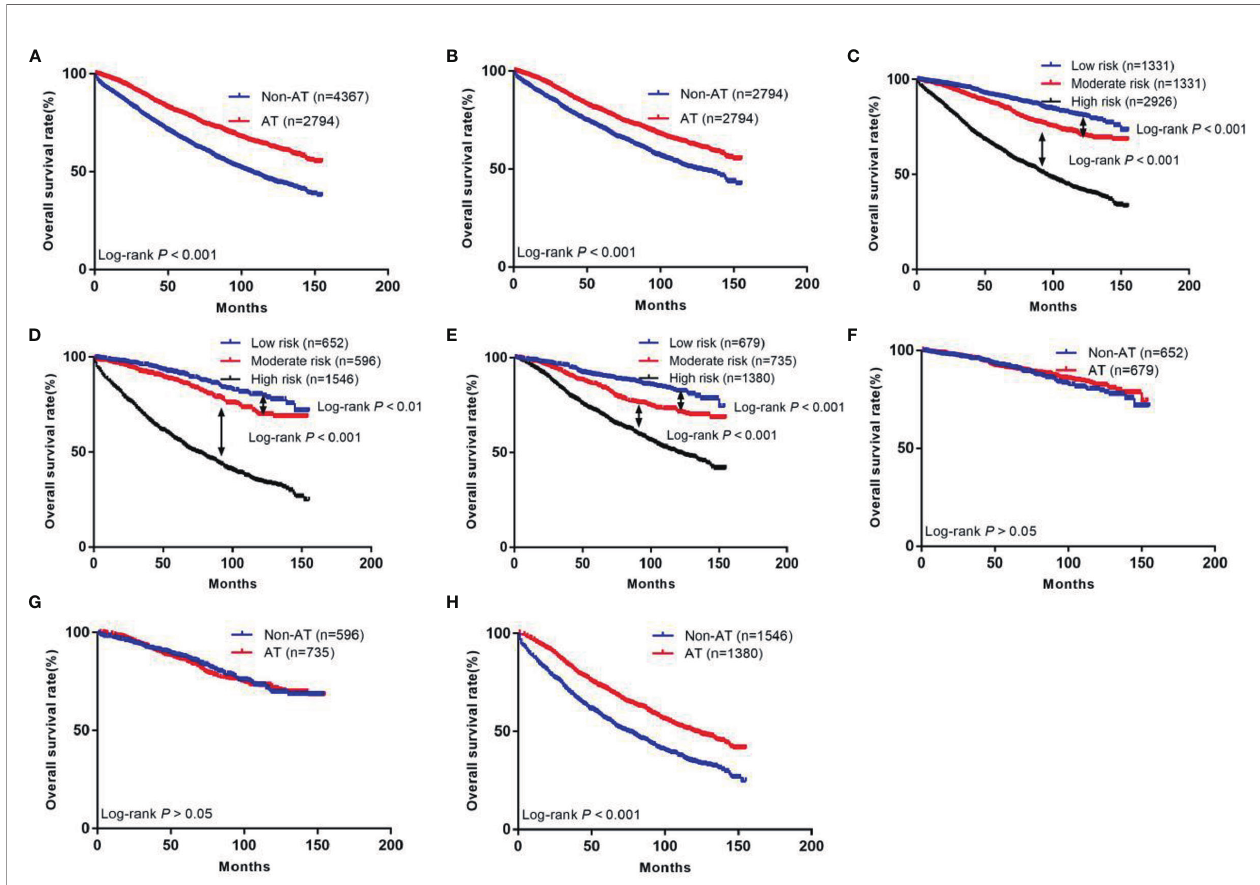
FIGURE 2 | The Kaplan-Meier curves of OS for patients in our study. (A) All patients; (B) Patients after PSM; (C) OS in different subgroups of all patients; (D) OS in different subgroups of non-AT group; (E) OS in different subgroups of AT group; (F) OS for patients with or without AT in low risk group; (G) OS for patients with or without AT in moderate risk group; (H) OS for patients with or without AT in high risk